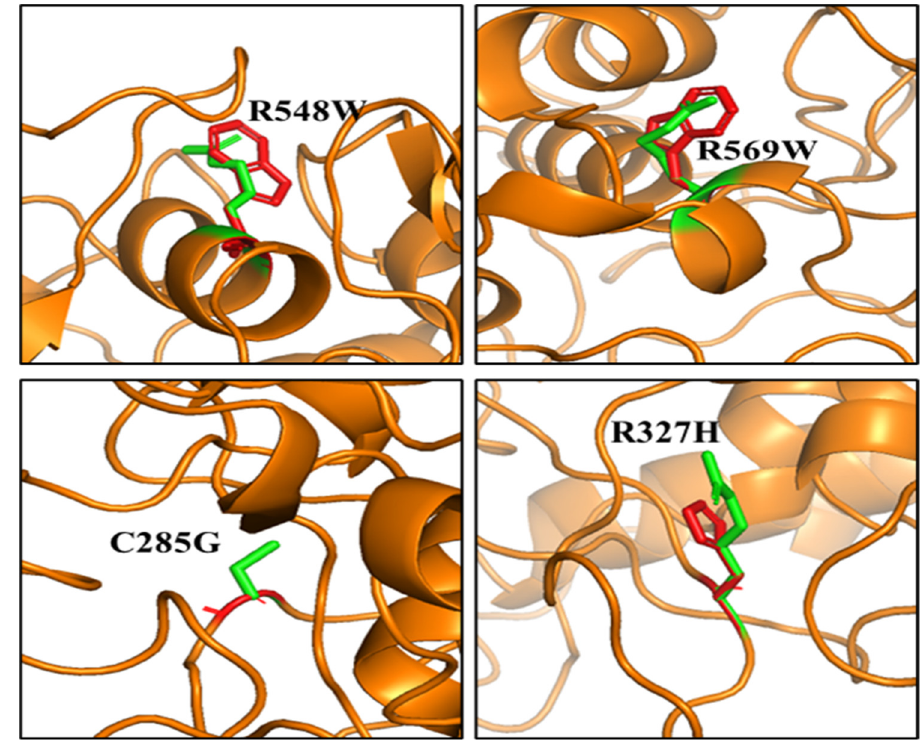
Figure 5. Structural representation of some disease-associated missense mutations of MPO; wildtype residues in Green; mutant residues in Red.